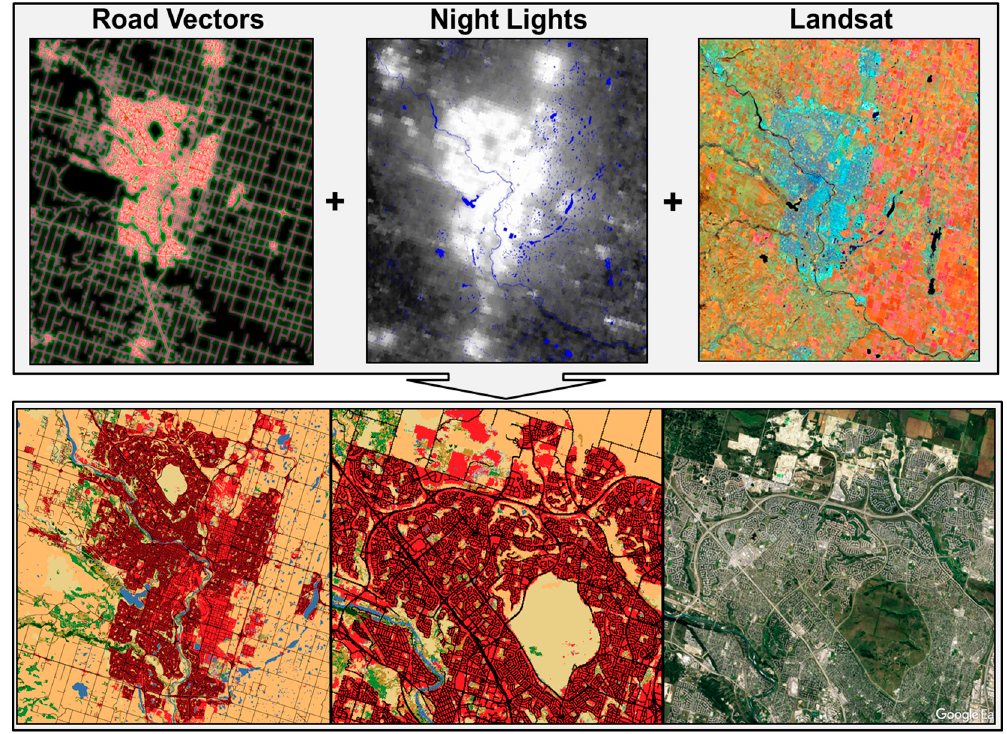
Figure 3. Approach used for mapping urban and built-up areas. True color image is from Google Earth for 2015.